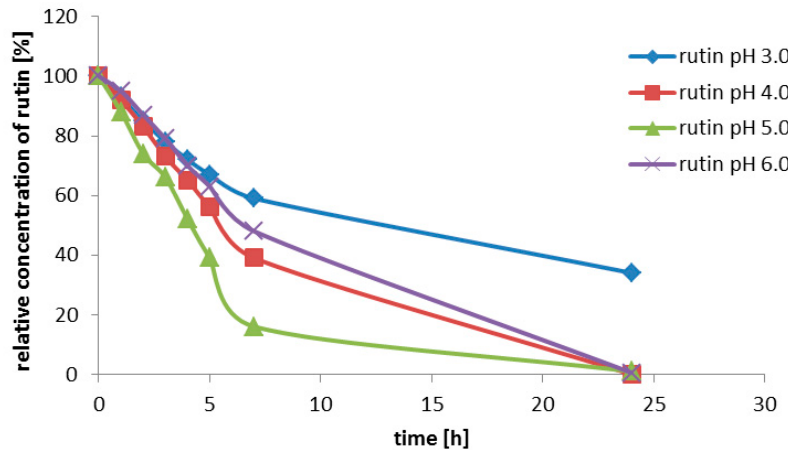
Figure 2. Bioconversion of rutin to quercetin using crude recombinant rutinosidase produced at